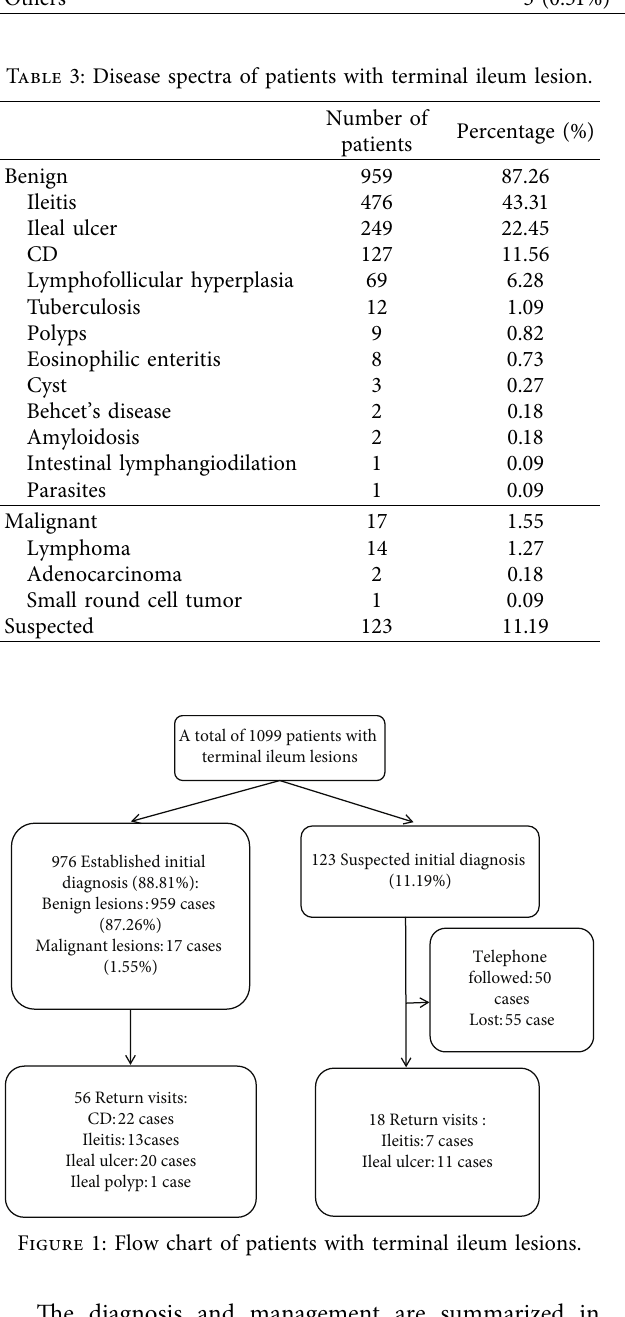
Table 4. The diagnosis was corrected in 18 of 74 patients (24.32%) with ileitis or ileal ulcer. Among the 56 return patients with established initial diagnosis by endoscopy at